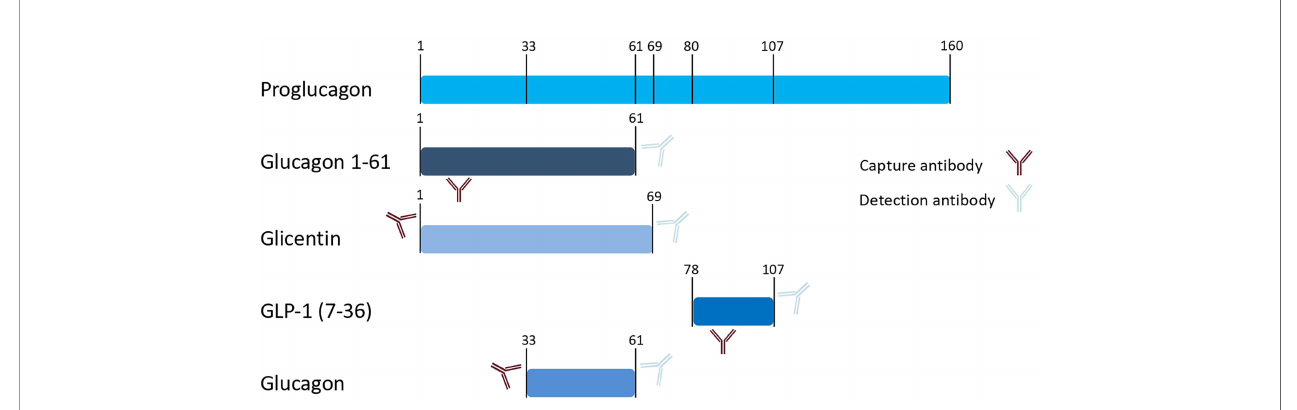
FIGURE 1 | Schematic presentation of proglucagon and proglucagon cleavage products. Numbers indicate amino acid positions of cleavage sites. Antibodies schematically indicate epitopes that are used by the commercial immunoassays applied in our measurements (as provided by the